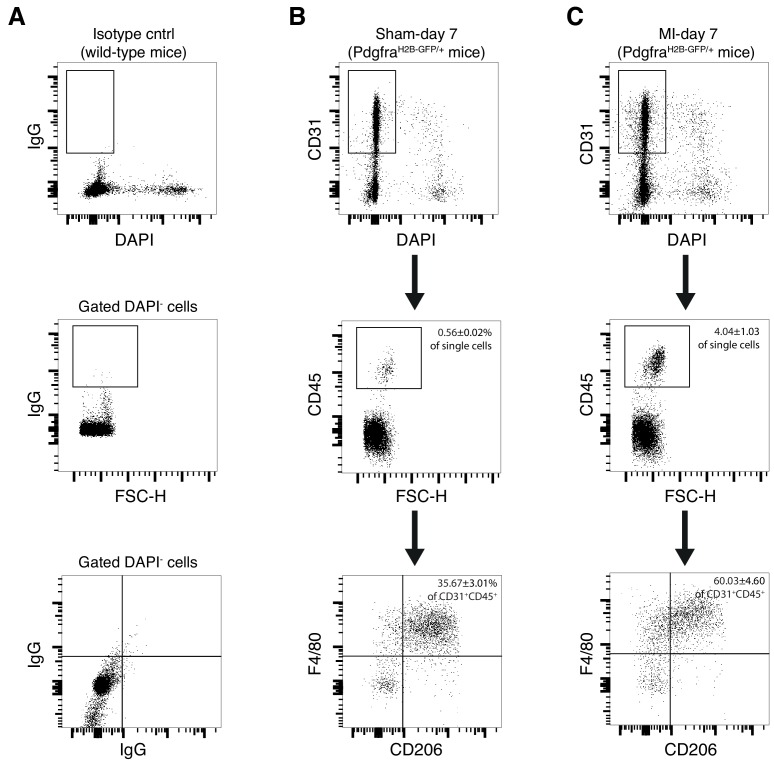
FACS data supporting the M2 MΦ -EC population.FACS plots showing expression of indicated antigen (axis label) in the (A) wild type sample stained with isotype control antibodies and PdfgraGFP/+ sample stained with indicated antibodies 7 days after Sham (B) or MI (C) surgery.Numbers indicate percentage of gated cells in live single cells in respective analyses (mean numbers indicated).